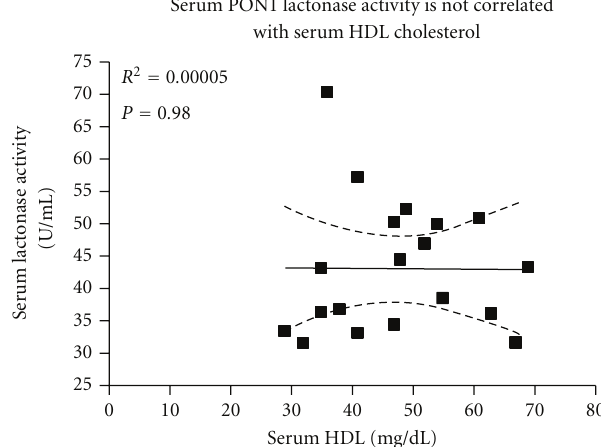
Figure 3: Serum PON1 activity versus serum HDL cholesterol. Serum PON1 activity is not correlated with serum HDL cholesterol